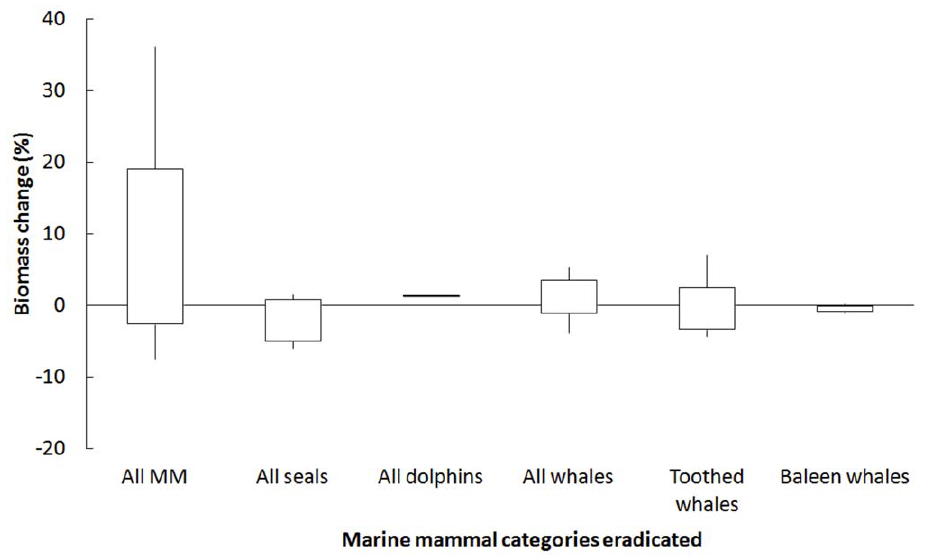
Figure 5. Total percentage of increase in the biomass of commercially important fishes when removing different groups of marine mammals. Boxes represent the lower 25% quartile up to the higher 75% quartile, while lines represent the smallest and the largest observations.